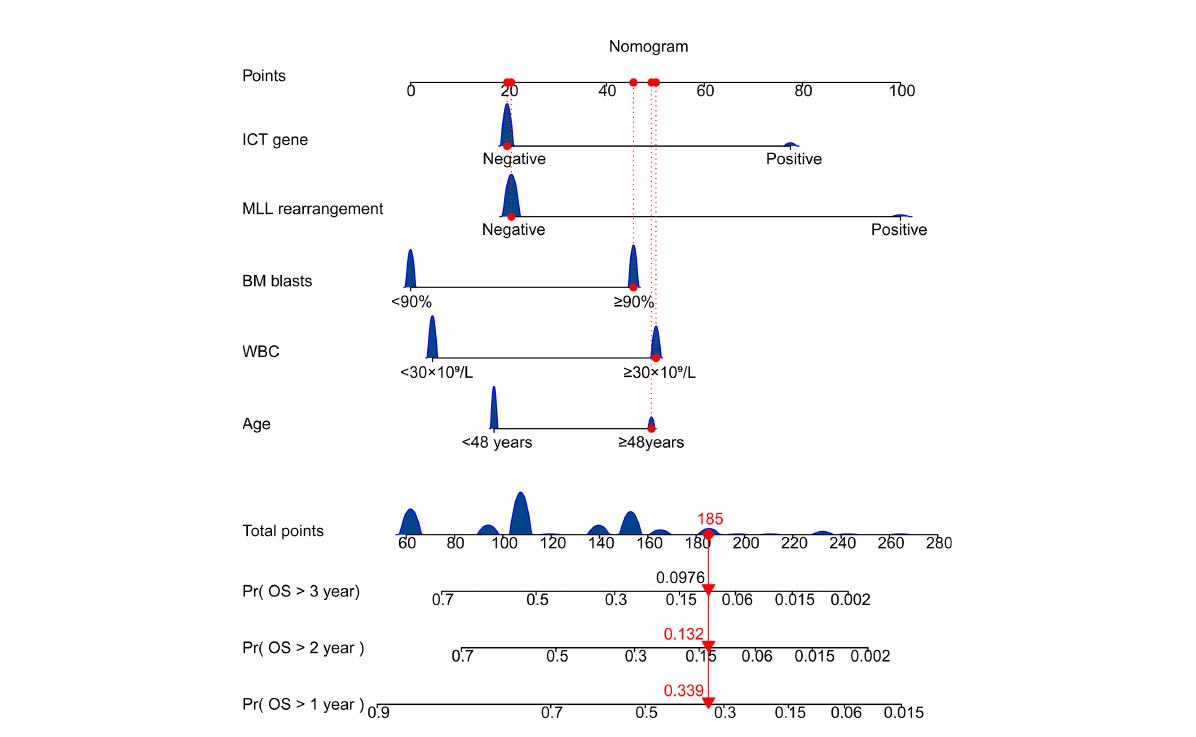
FIGURE 3 Nomogram for predicting overall survival of patients with ALL. Age ≥ 48 years; WBC ≥ 30 × 10 9 /L; BM blast ≥ 90%; the presence of MLL rearrangement; ICT gene if carried one or more of IKZF1 , CREBBP and TP53 . BM, bone marrow; WBC, white blood cell counts; OS, overall